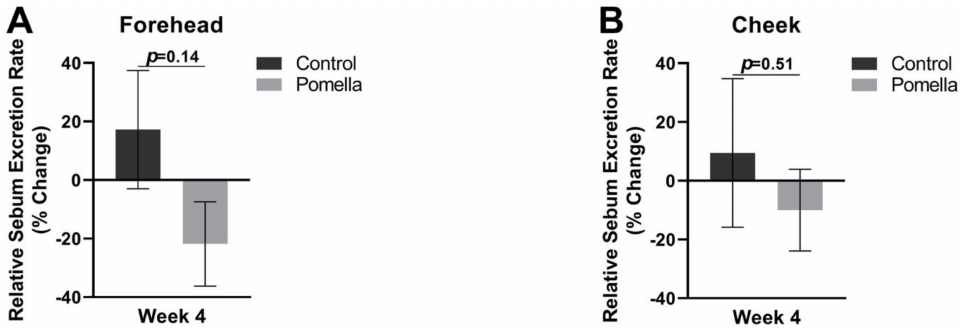
Figure 3. The sebum excretion rate in the Control and PE groups relative to pre-treatment baseline. Sebum was measured with a sebumeter and week 4 measures were compared against baseline on the forehead ( A ) and on the cheek ( B ).